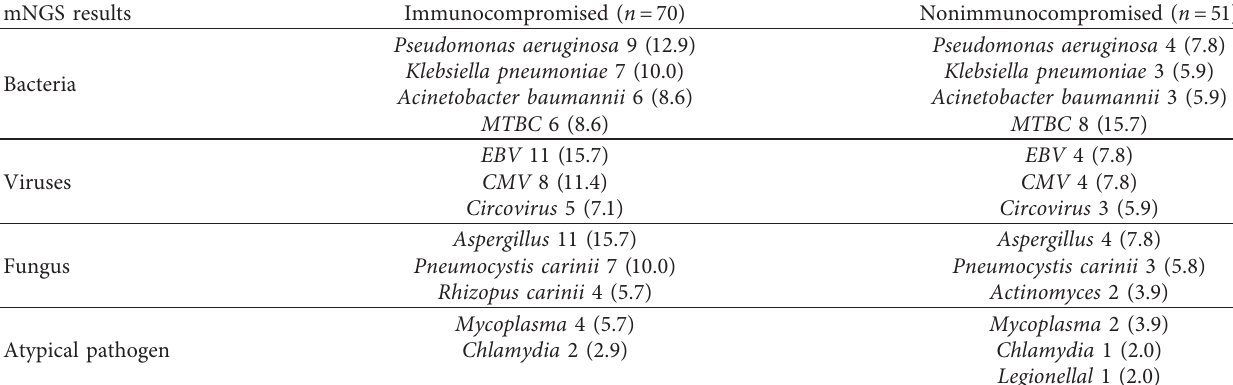
Table 3: The most commonly identified pathogens by mNGS in 121 patients ∗ .